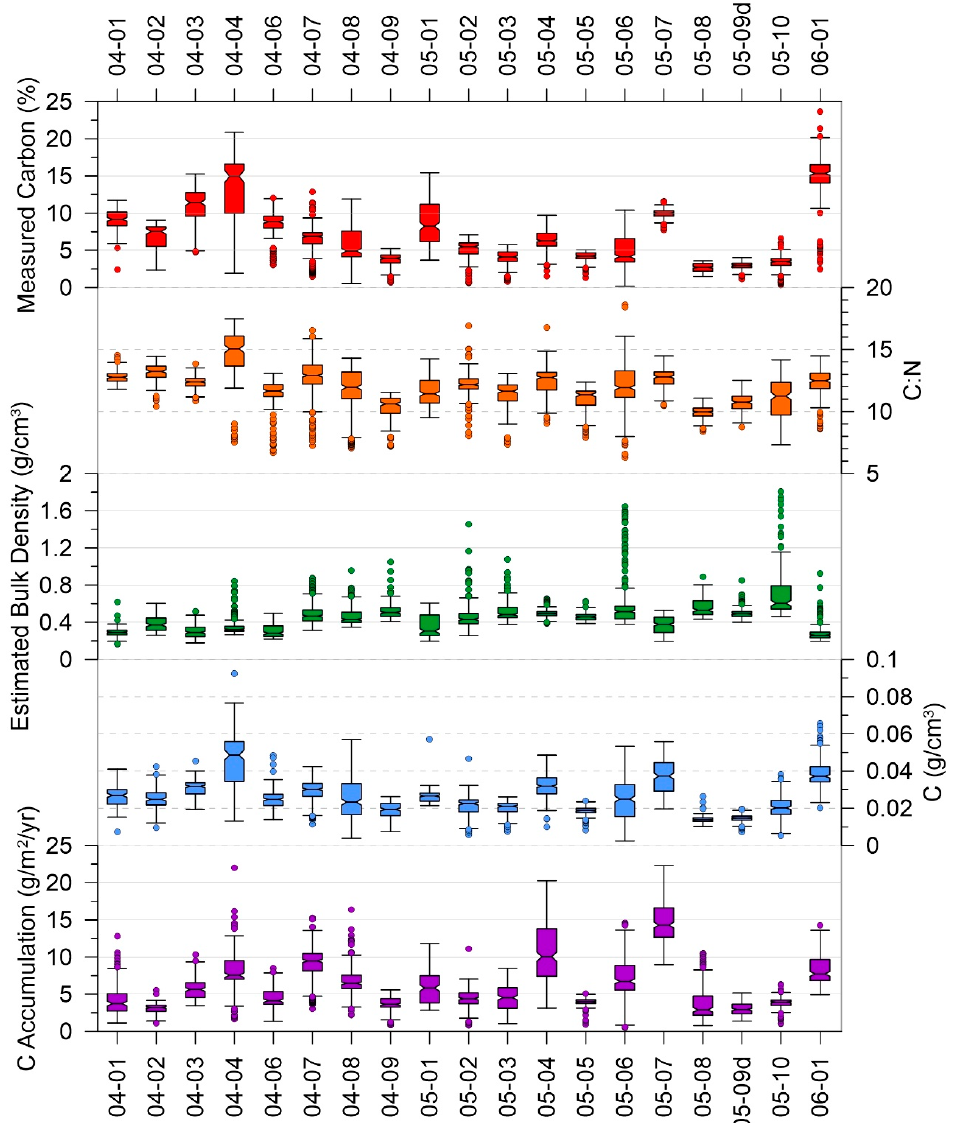
Figure 6. Measured percent carbon, C:N ratio, estimated bulk density, calculated carbon content, and carbon accumulation rate in the Holocene section (11,700 BP to present) of 19 Uinta lake sediment cores.